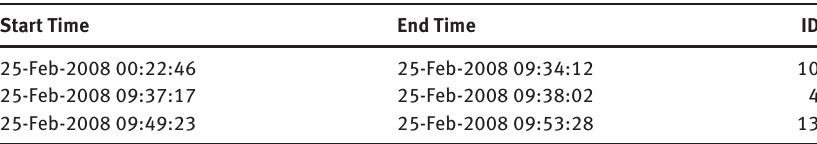
Table 1: Event Logs Dataset Structure. Start